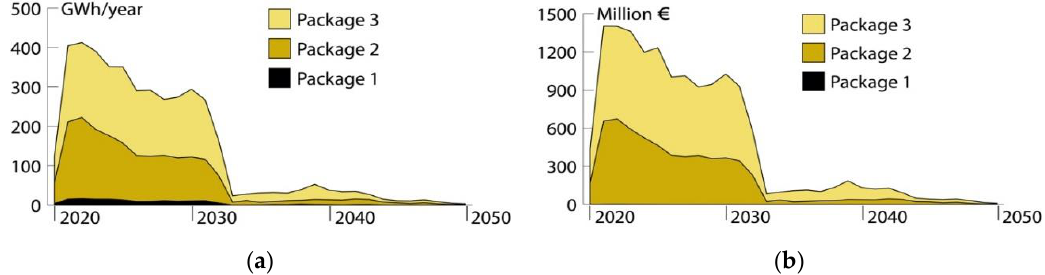
Figure 8. The figure shows yearly, cumulative: ( a ) Energy savings potential from the different energy retrofitting packages and ( b ) The associated costs. The results are based on the energy retrofitting strategy presented in Figure 7 and the referred energy retrofitting packages [44]. This figure is based on the assumption that buildings that are not suitable for additional façade insulation are not allocated Package 3, and that buildings are refurbished, and energy retrofitted when they reach their expected service life of 50 years. The expected service life has been adjusted based on previous refurbishments, and pent-upped needs for refurbishment have been evenly distributed between year 2020 and